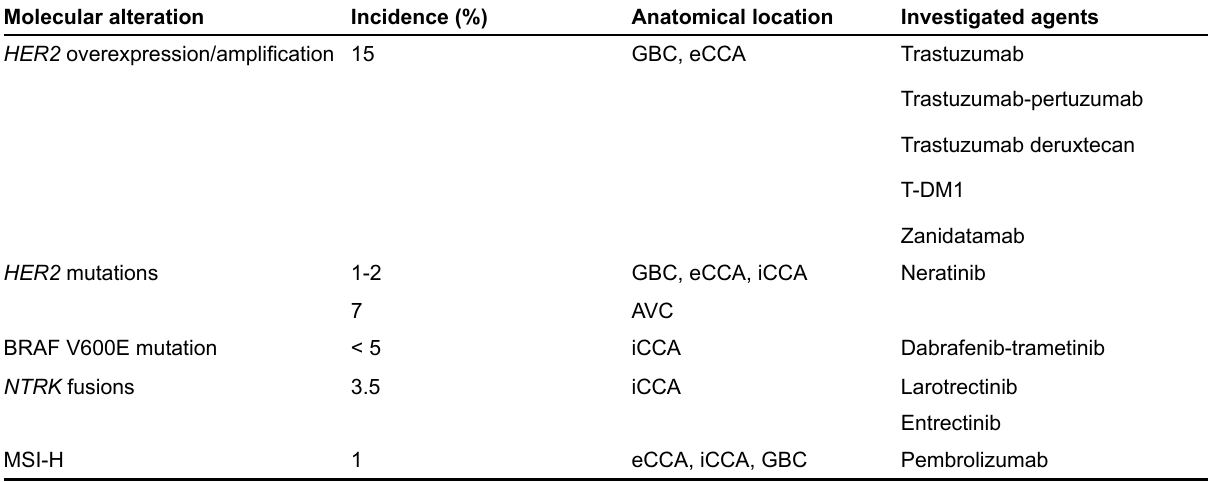
Table 1 . Relevant targetable aberrations in BTCs ( continued ) Molecular